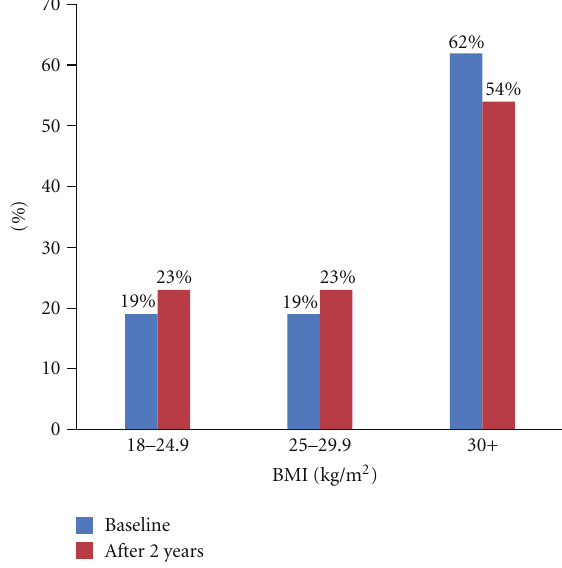
Figure 1: Changes in body mass index among health club partici- pants over a 2 year